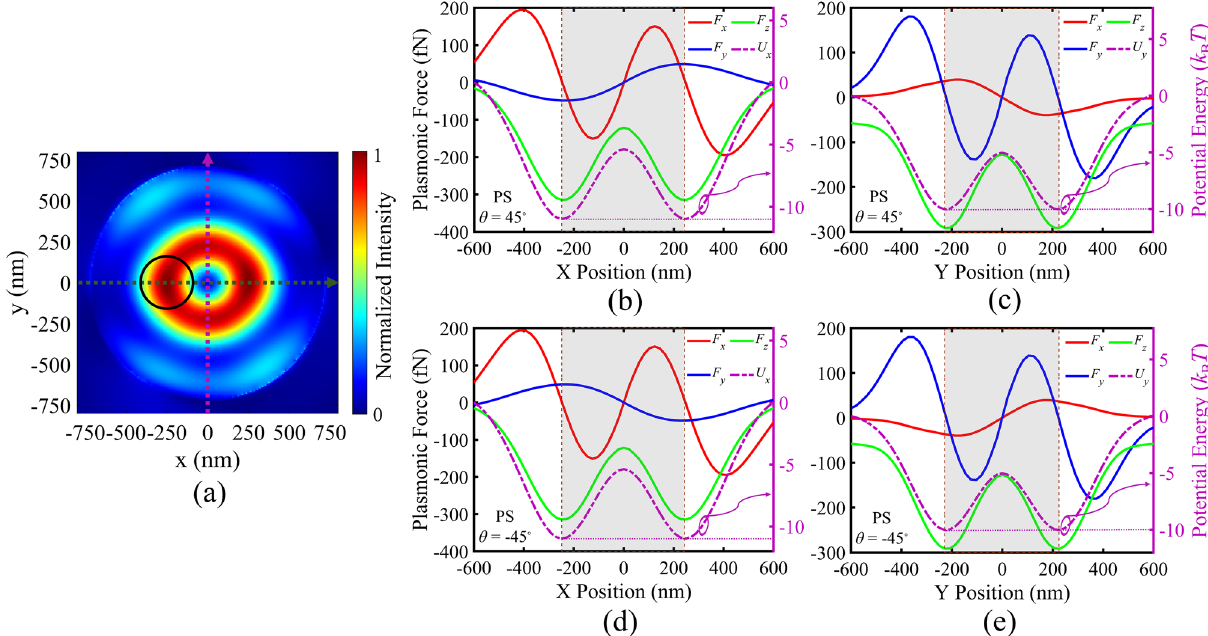
Figure 3. ( a ) Directions of PS particle movement tracks with respect to the normalized field intensity distribution of the generated PV in MIM structure (design I). Plasmonic force analysis for a PS particle (shown by black circle in part ( a )) with the radius of 160 nm in the PV field: ( b , c ) Calculated plasmonic forces F x , F y , F z and the corresponding potential wells at various x -offsets and y -offsets of the particle center, for θ = 45°, ( d , e ) Calculated plasmonic forces F x , F y , F z and the corresponding potential wells at various x -offsets and y -offsets of the particle center, for θ = − 45°.